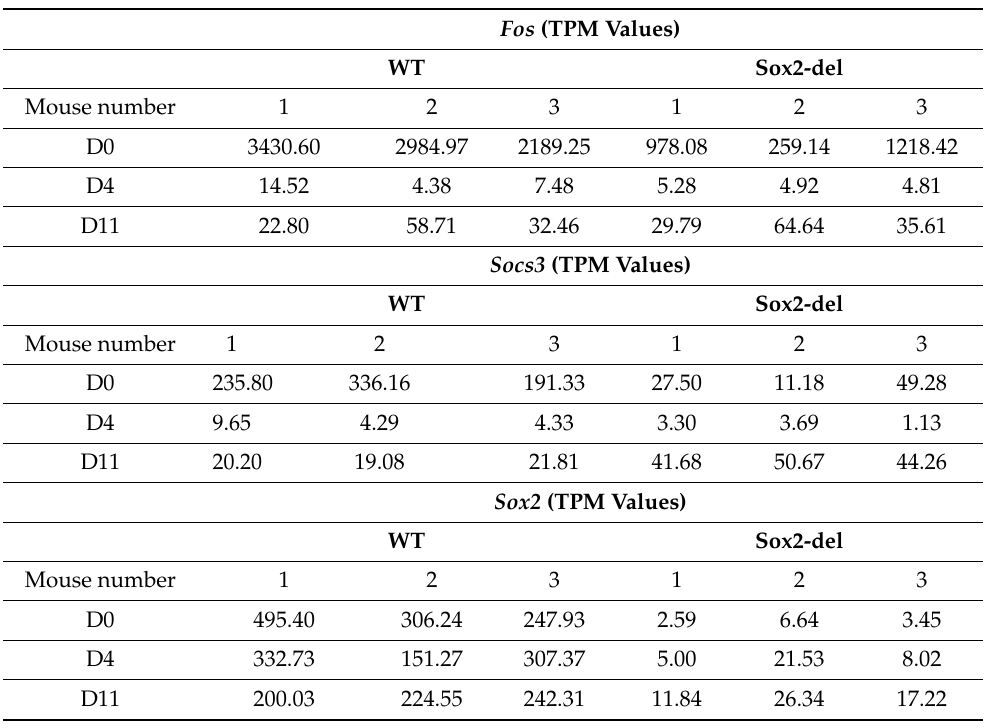
Table 1. Levels of Fos (A), Socs3 (B), and Sox2 (C) mRNA, in wild-type and Sox2-del cells during NSC differentiation (D0, D4, D11). Three wild-type (WT) and three Sox2 mutant (Sox2-del) mice were used to generate NSC cultures that were then analyzed at D0, D4, and D11 by RNA-seq. TPM, transcripts per million. D0 values are from our previous work [8]; D4 and D11 genome-wide RNA-seq data are reported in Table S1. The slight increase of the ratio of Sox2 mRNA in Sox2-del versus WT at D4 and D11 might be due to preferential proliferation at early stages of differentiation, or better survival, of rare Sox2-positive cells present at